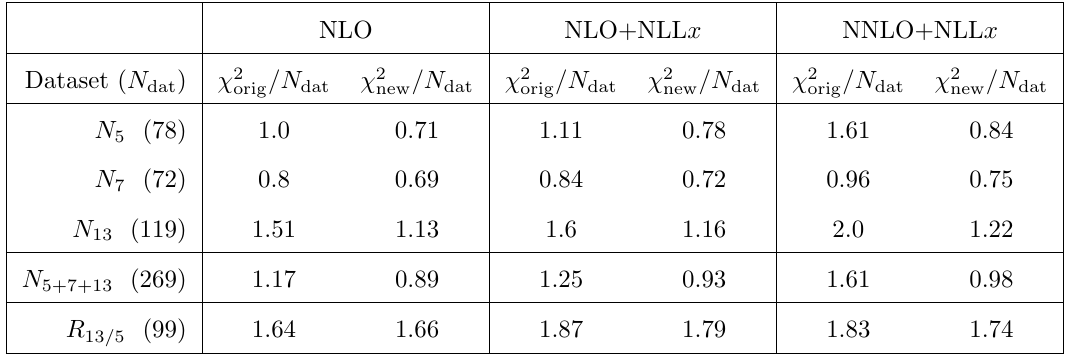
Table 1 . The values of the (cid:31) 2 per data point, (cid:31) 2 =N dat , for each of the LHCb D -meson production datasets considered in this analysis. Each centre-of-mass energy contains the results of all the D - meson species considered. For each of the three theory settings, we show the results both before ( (cid:31) 2 ) and after ( (cid:31) 2 ) adding the LHCb data into the (cid:12)t. In the (cid:12)rst column we also indicate the new orig values of N dat for each dataset. In this work the results based on the N 5+7+13 dataset are taken as the